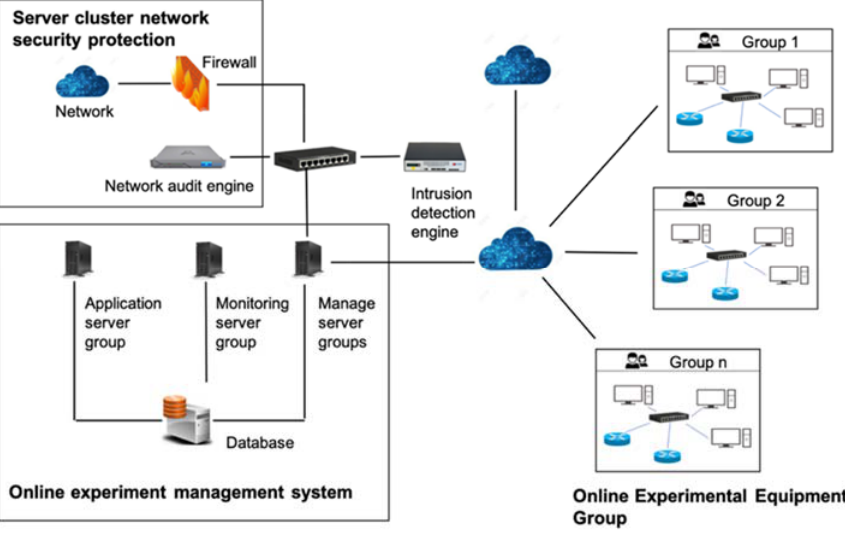
Figure 1. Overall structure diagram of the computer network online experiment platform.